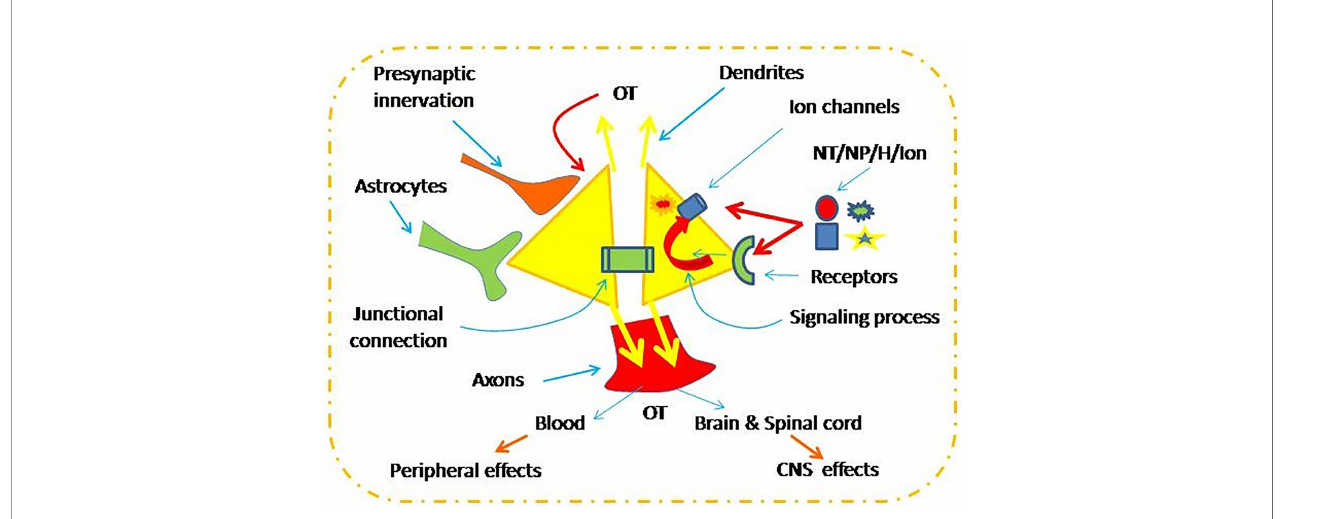
FIGURE 1 | Neurochemical regulation of oxytocin (OT) neuronal activity. CNS, the central nervous system; NT/NP/H/Ion, neurotransmitters, neuropeptide, hormone and